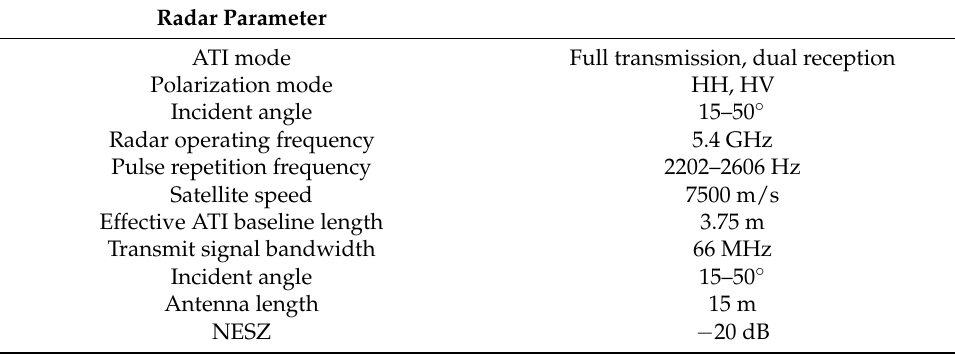
Table 3. Specification of SLC